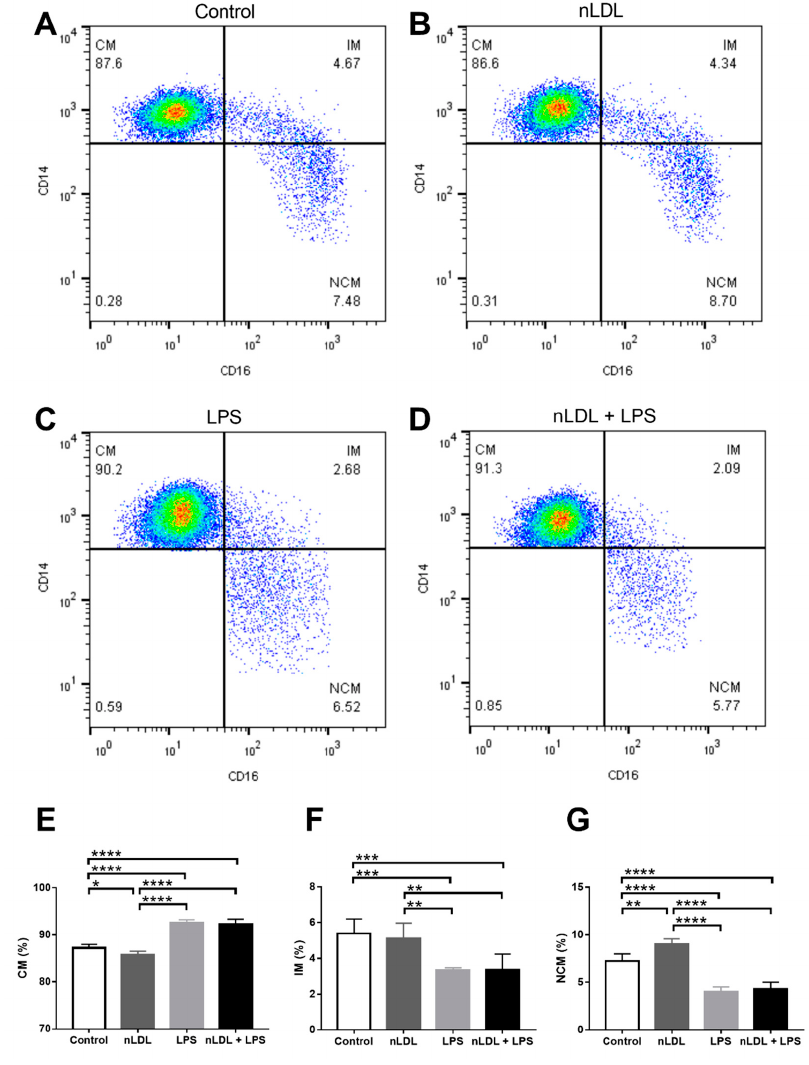
Figure 2. Effects of nLDL and LPS on the dynamics of human monocyte subpopulations. Representative plots showing the percentages of CMs, IMs, and NCMs in response to control conditions ( A ), nLDL ( B ), LPS ( C ), or a combination of nLDL + LPS ( D ). nLDL significantly decreased the CM percentage and increased the amount of NCMs as compared to control cells ( E , G , respectively). LPS, alone or in combination with nLDL, significantly increased the CM percentage and decreased the amount of IMs and NCMs ( E – G , respectively). Cells were incubated in the presence or absence of 100 μ g/mL nLDL and/or 10 ng/mL LPS for 9 h. Data are expressed as mean ± standard deviation. Data were compared using one-way ANOVA followed by the post-hoc Tukey test. Differences were considered significant when p < 0.05. * = p < 0.05; ** = p < 0.01; *** = p < 0.001; **** = p < 0.0001. CM, classical monocytes; IM, intermediate monocytes; NCM, non-classical monocytes; nLDL, native low-density lipoproteins; LPS, lipopolysaccharide. Exposure of cells to nLDL and LPS not only affected the balance among monocyte subpopulations but also their ability to produce IL-1 beta, a cytokine with key